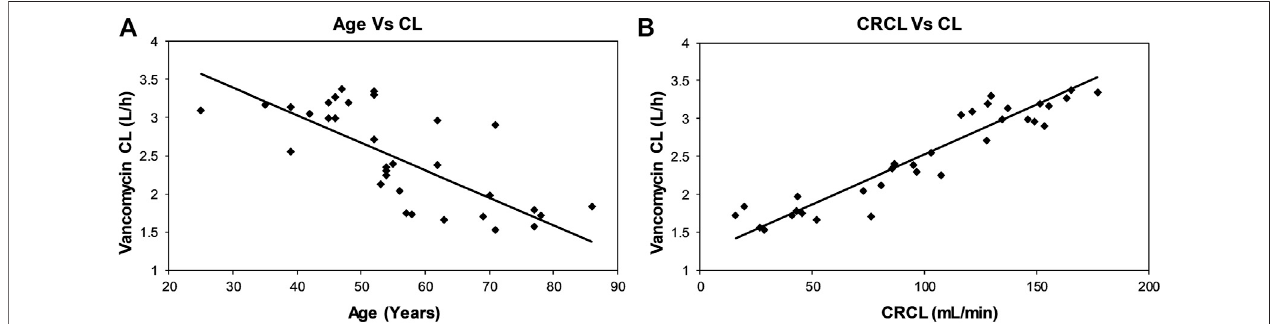
FIGURE 1 | Scatterplots showing relationships between vancomycin CL and age (A) and CRCL (B) of the patients.